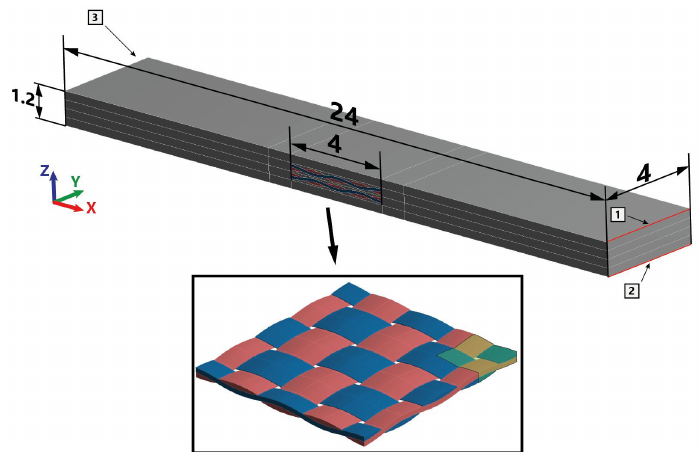
Figure 1. Geometry of the DCB model. Geometry which represents weave fabric is present in the middle of the element. Numbers in squares depict boundary conditions applied to the model. The zoomed section represents one of the detailed zones. One of the 16 Representative Volume Elements (RVE) that build the upper weave pattern is highlighted. Units in mm.